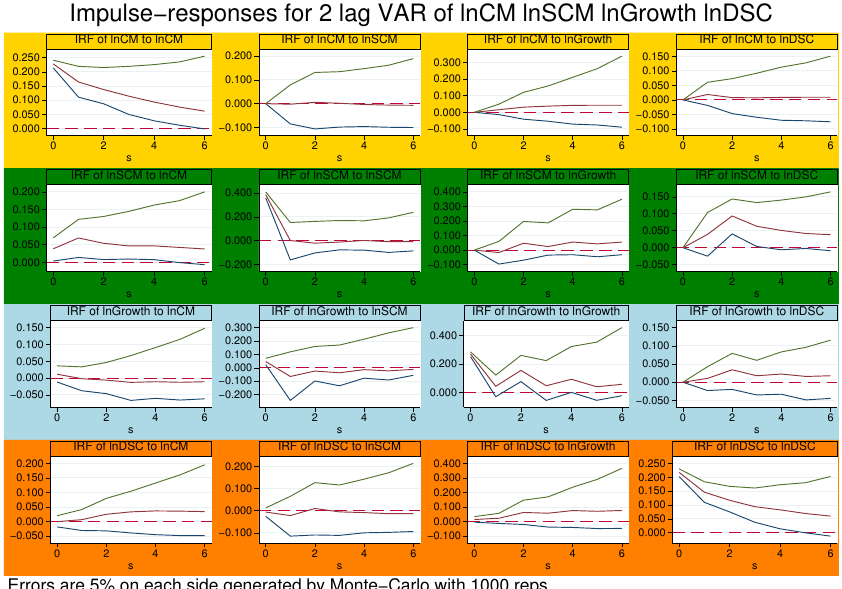
Figure 10. The first row (in yellow) indicates, respectively, the impulse response of corporate man- agement to itself (lnCM), supply chain management (lnSCM), growth capacity (lnGrowth), and debt service capacity (lnDSC); the second row (in green) indicates, respectively, the impulse responses of supply chain management to corporate management (lnCM), itself (lnSCM), growth capacity (lnGrowth), and debt servicing capacity (lnDSC); the third row (in light blue) indicates, respectively, the impulse responses of growth capacity to corporate management (lnCM), supply chain manage- ment (lnSCM), itself (lnGrowth), and debt servicing capacity (lnDSC); the fourth row (in orange) indicates, respectively, the impulse responses of debt servicing capacity to corporate management (lnCM), supply chain management (lnSCM), growth capacity (lnGrowth), and itself (lnDSC).